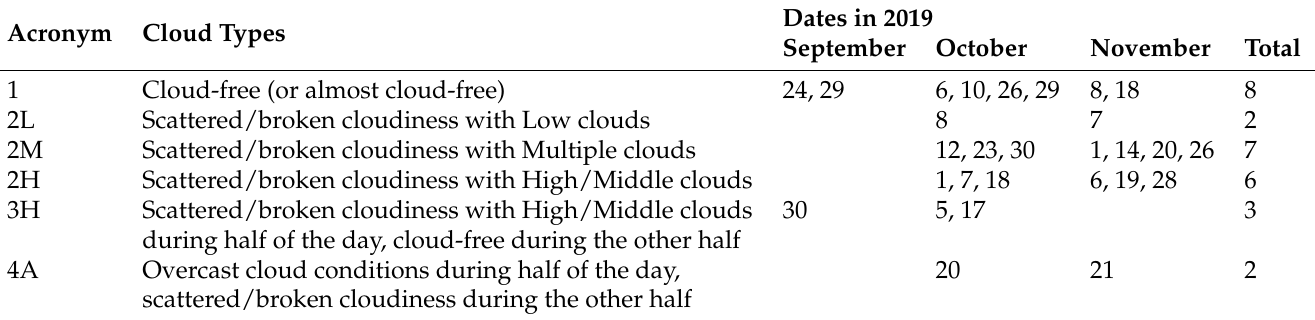
Table 1. Cloud clusters and the corresponding number of available evaluation